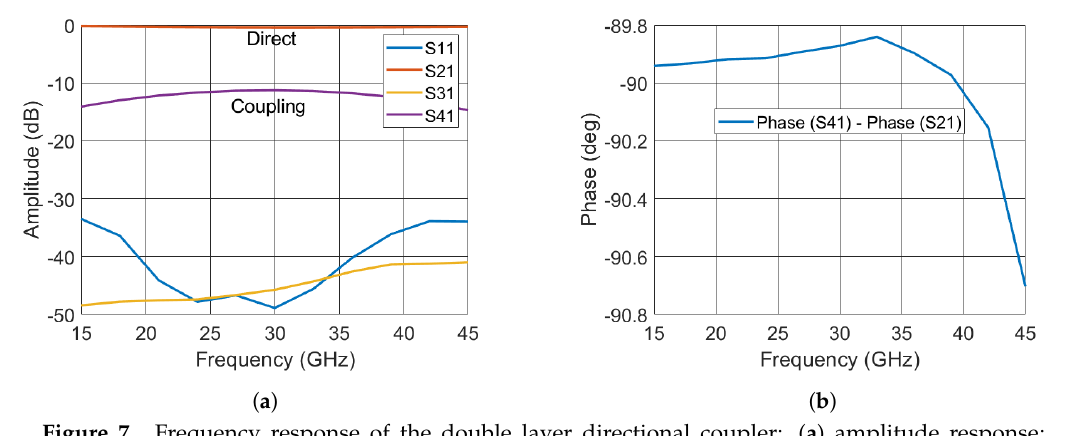
Figure 7. Frequency response of the double layer directional coupler: ( a ) amplitude response; and ( b ) phase difference between the output ports of the double layer directional